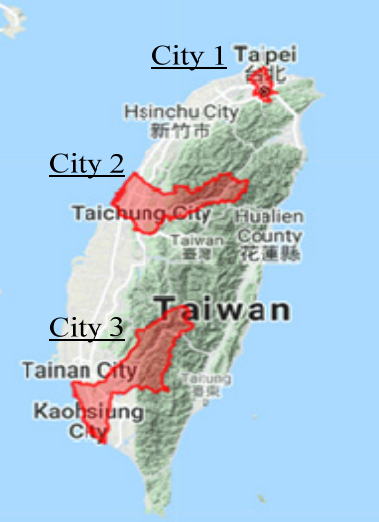
Figure 9. The polygons of targeted cities. The red areas are the corresponding polygons of City 1, City 2, and City 3.